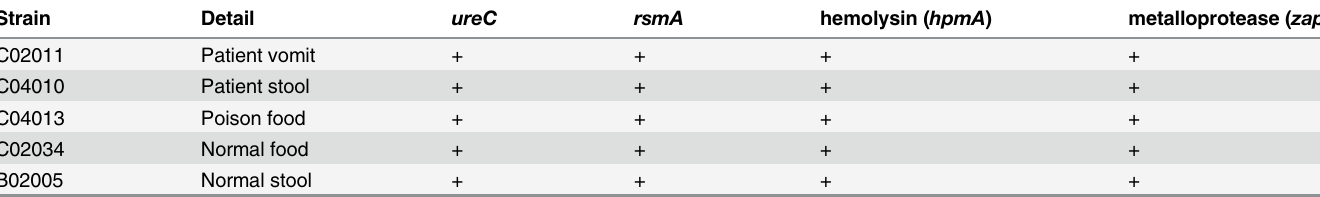
Table 2. Currently adopted molecular typing technologies of biomarker genes in the infectious bacterial strains. Strain Detail